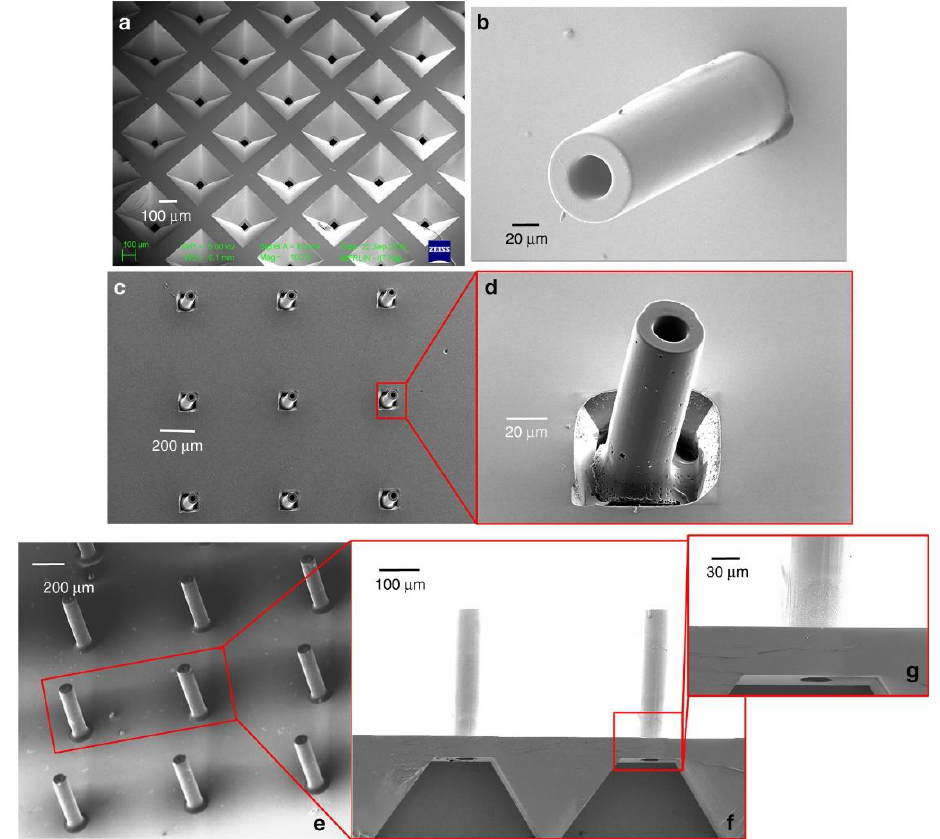
Figure 11. ( a ) Etched microfluidic conduit in silicon through which the drug flows from the drug reservoir to the CMN. ( b ) SMN fabricated on a microfluidic conduit backside of the image shown in ( a ). ( c ) CMN array formed after pyrolysis. ( d ) Magnified view of a CMN. ( e ) Optimized CMNs aligned on etched microfluidic ports on a silicon wafer. ( f , g ) Magnified images of the CMNs and the underlying flow channel. Reprinted from Mishra et al. [65] with permission from Springer Nature.